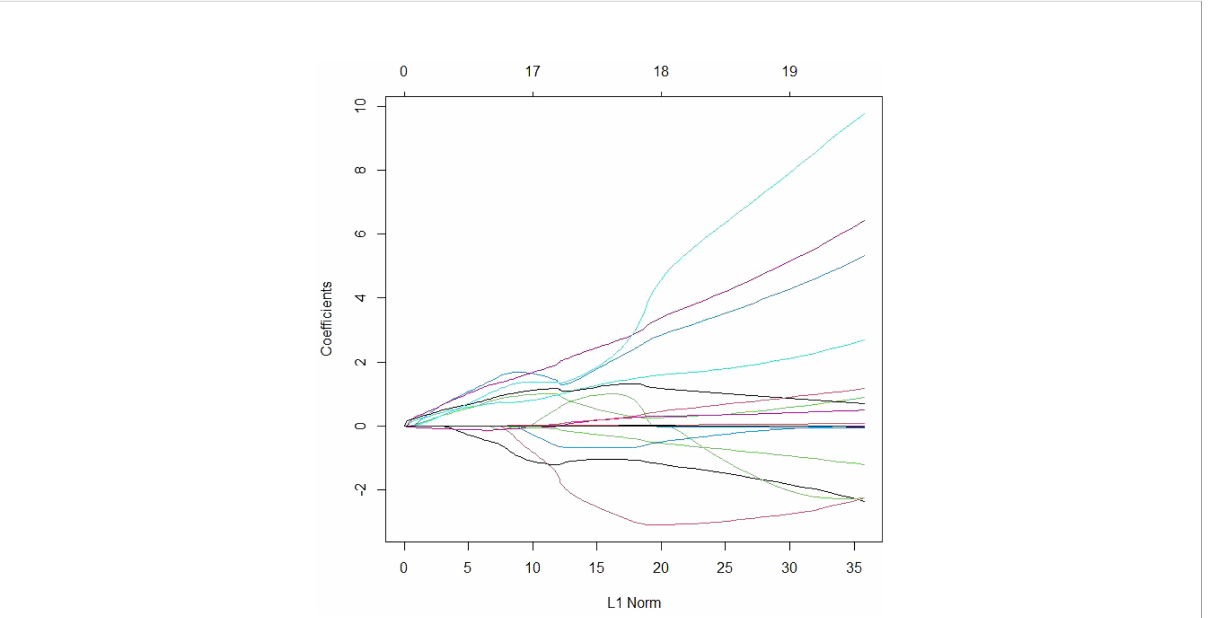
FIGURE 2 Variable selection using the LASSO logistic Poisson model. LASSO model coef fi cient pro fi les of the 19 candidate variables. The logistic regression coef fi cients are estimated with an upper bound ( “ L1 norm ” ) to the sum of the absolute standardized regression coef fi cients. The L1 norm regularization term typically shrinks many regression coef fi cients to 0.